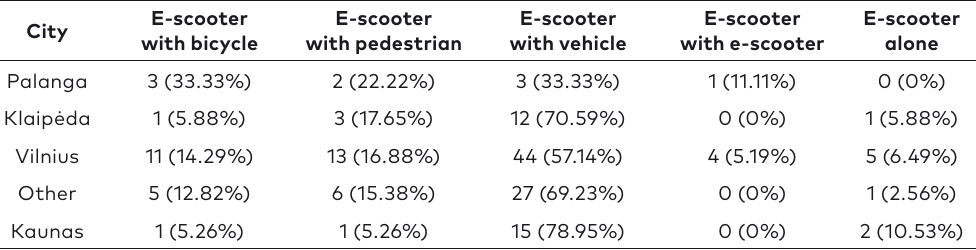
Table 8. The distribution of e-scooter accidents by day of the week and by city